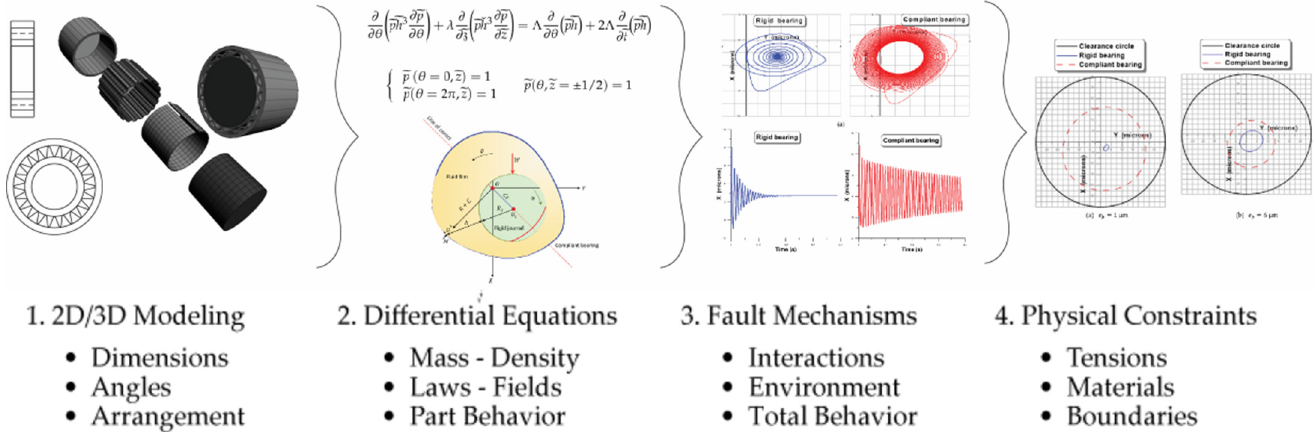
Figure 3. Basic illustration of the creation of one complete part of the DT, as described in [38]. An important aspect of the DT is the 3D representation of the object, including physical flaws. Incorporating geometries with differential equations systems allows for greater freedom in simulation. Typical usage of FEM software. Images for illustration purposes only, courtesy of [40].